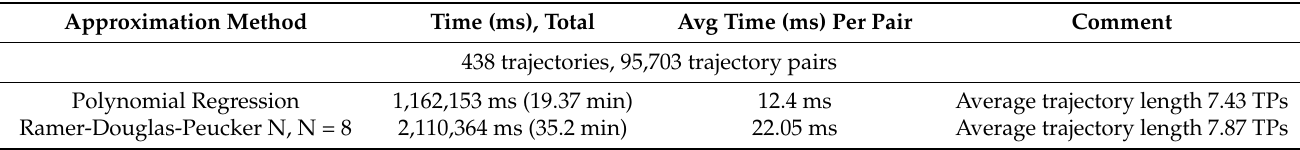
Table 3. LCSS distances calculation.